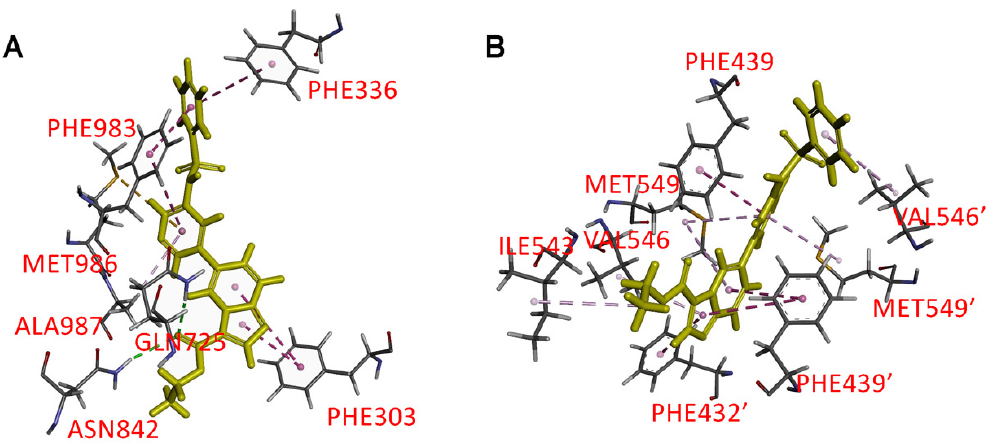
Figure 7. The lowest energy poses for the docking binding of HS-173 within the drug-binding pocket of ( A ) ABCB1 (PDB:6QEX) and ( B ) ABCG2 (PDB: 6VXH) were predicted using BIOVIA Discovery Studio 4.0 software as described in the Materials and Methods section. The molecular model of HS-173 is presented in (yellow) stick representation, and the atoms for interacting amino acid residues are colored: carbon (gray), oxygen (red), nitrogen (blue), hydrogen (light gray), and sulfur (yellow). Dashed lines represent the proposed interactions. The residues from monomer 2 of ABG2 are indicated with prime